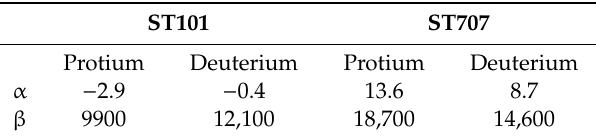
Table 2. Di ff usivity coe ffi cients of H and D in ST101 and